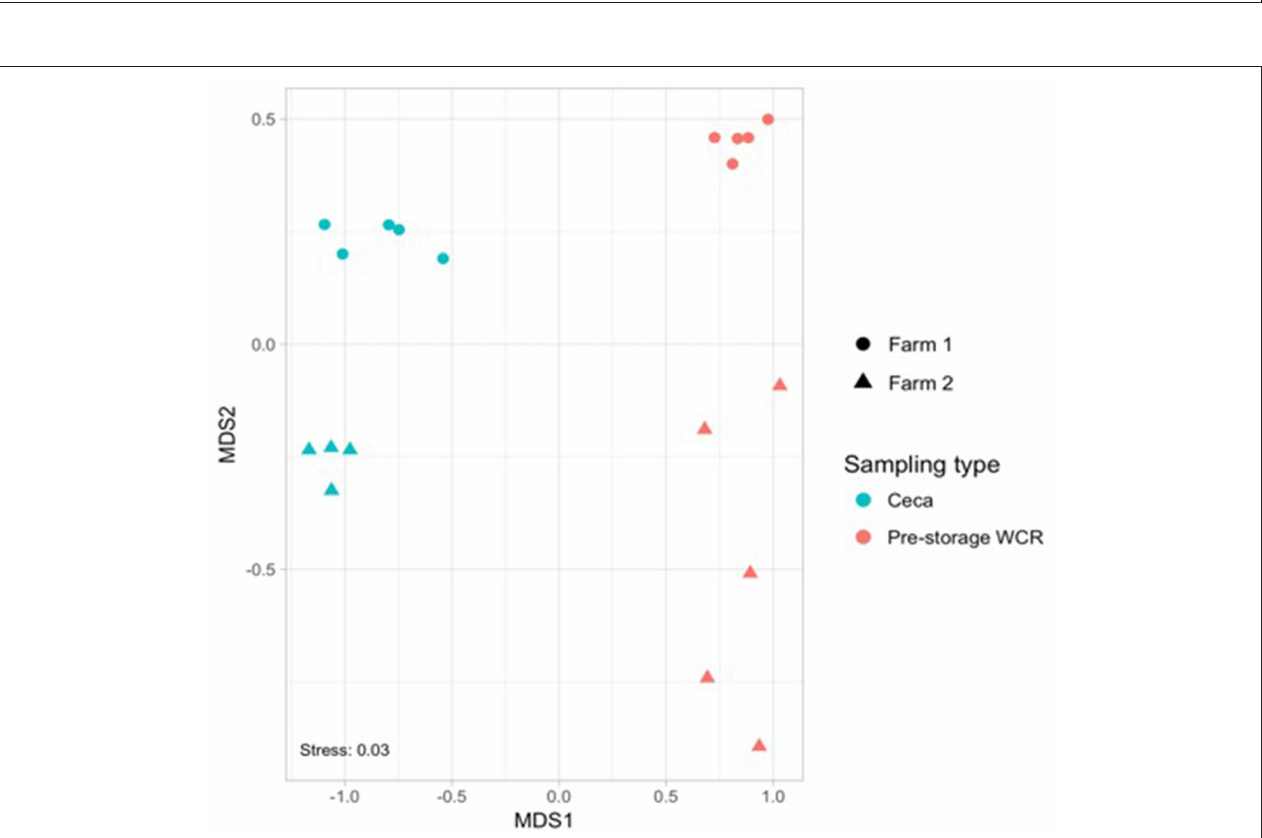
Frontiers in Sustainable Food Systems |